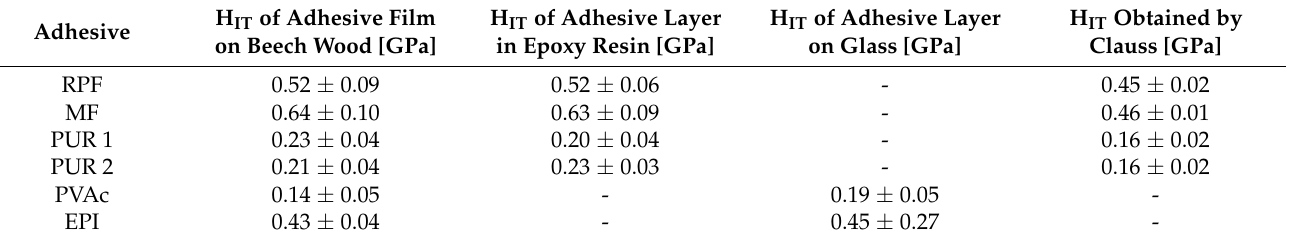
Table 6. Hardness measured by means of nanoindentation (H IT ) at 20 ◦ C, of the adhesive films and layers, compared to the values from the literature [2].